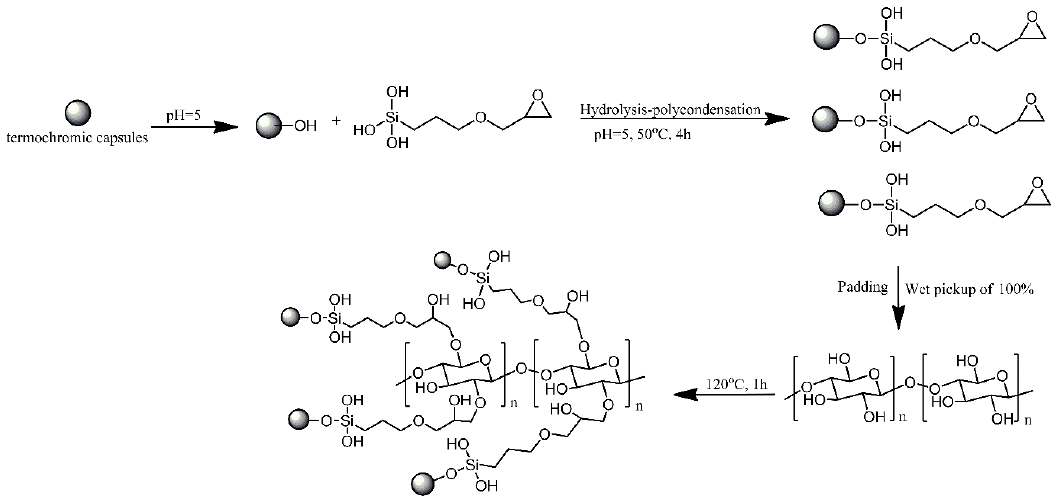
Figure 3. Schematic of thermochromic functionalized cotton fabric with epoxy modified thermochromic capsule. Based on Ref. [4].